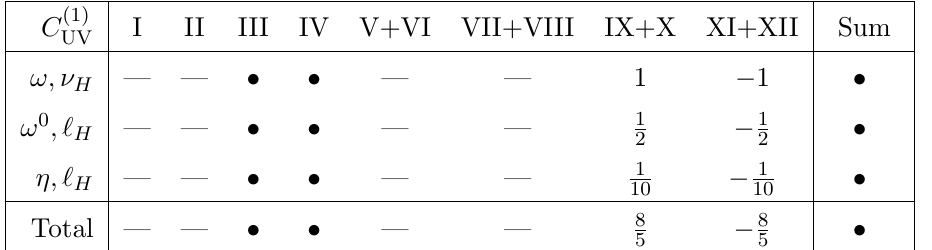
Table 6 . Divergent contributions proportional to 1 , with (cid:15) = 4 (cid:0) d the extra dimensions in dimen- (cid:15) sional regularization, of each particle set running in the loop and topology in (cid:12)gure 1 contributing at O (1). A dash means that the (cid:12)eld set does not run in the diagram, whereas a dot indicates that the in(cid:12)nite and (cid:12)nite parts